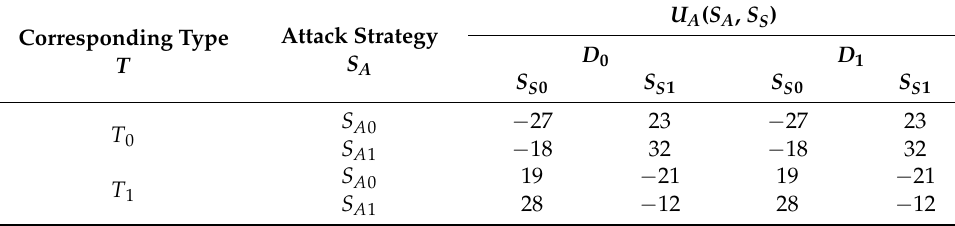
Table 7. Incomes of the Attacker.